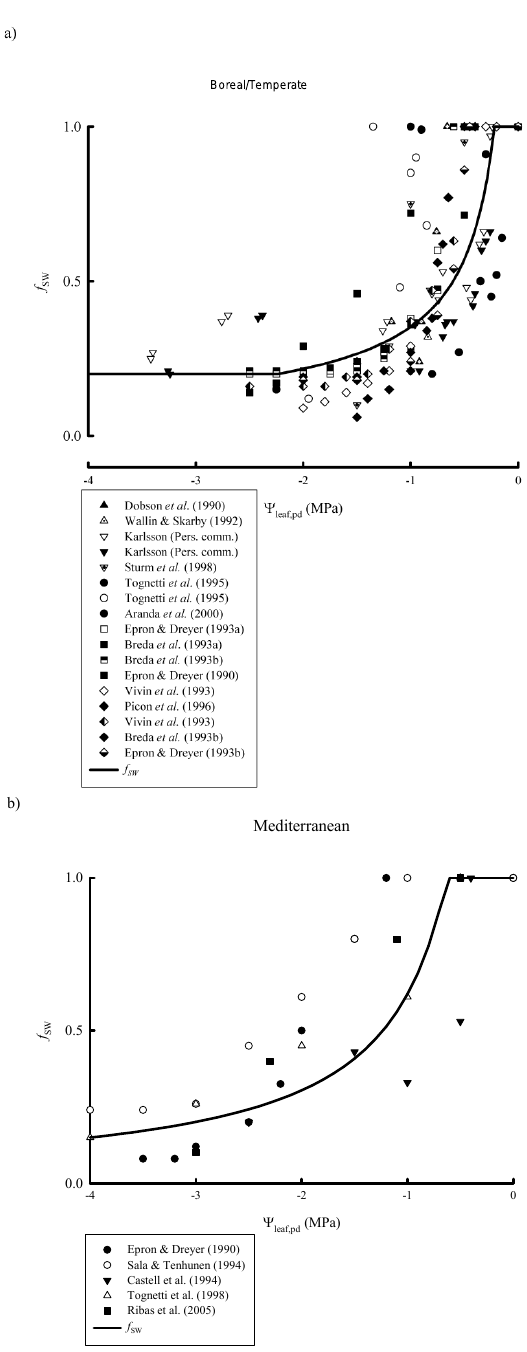
Fig. 2. f SW relationships in comparison with observed data describing relative g sto with pre-dawn leaf water potential ( 9 leaf, pd ) for (a) coniferous (Norway spruce and Scots pine) and deciduous (beech) trees in north and central Europe with 9 max = − 0 . 6MPa; 9 min = − 1 . 5MPa; PWP= − 4 . 0MPa and (b) Mediterranean trees (Holm oak) with 9 max = − 0 . 9MPa; 9 min = − 3 . 6MPa; PWP= − 4 .